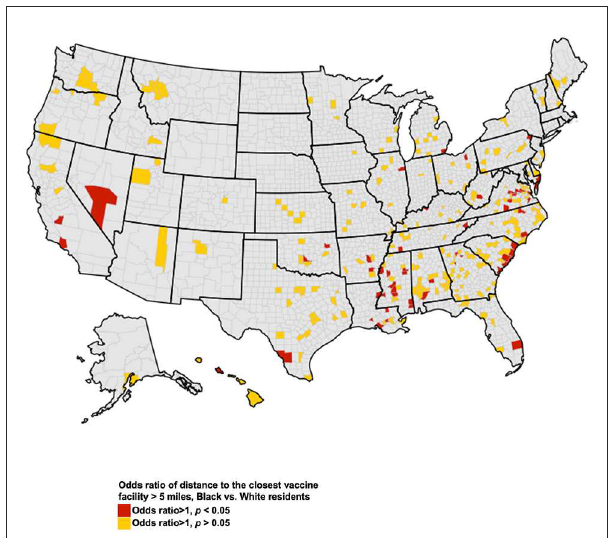
FIGURE2 Counties with disparities in access to health care facilities. The map represents counties where Black residents had higher odds of having a driving distance > 5 miles to the closest health care administration facility, compared to White residents. Red indicates counties where these disparities were significant at the p < 0.05